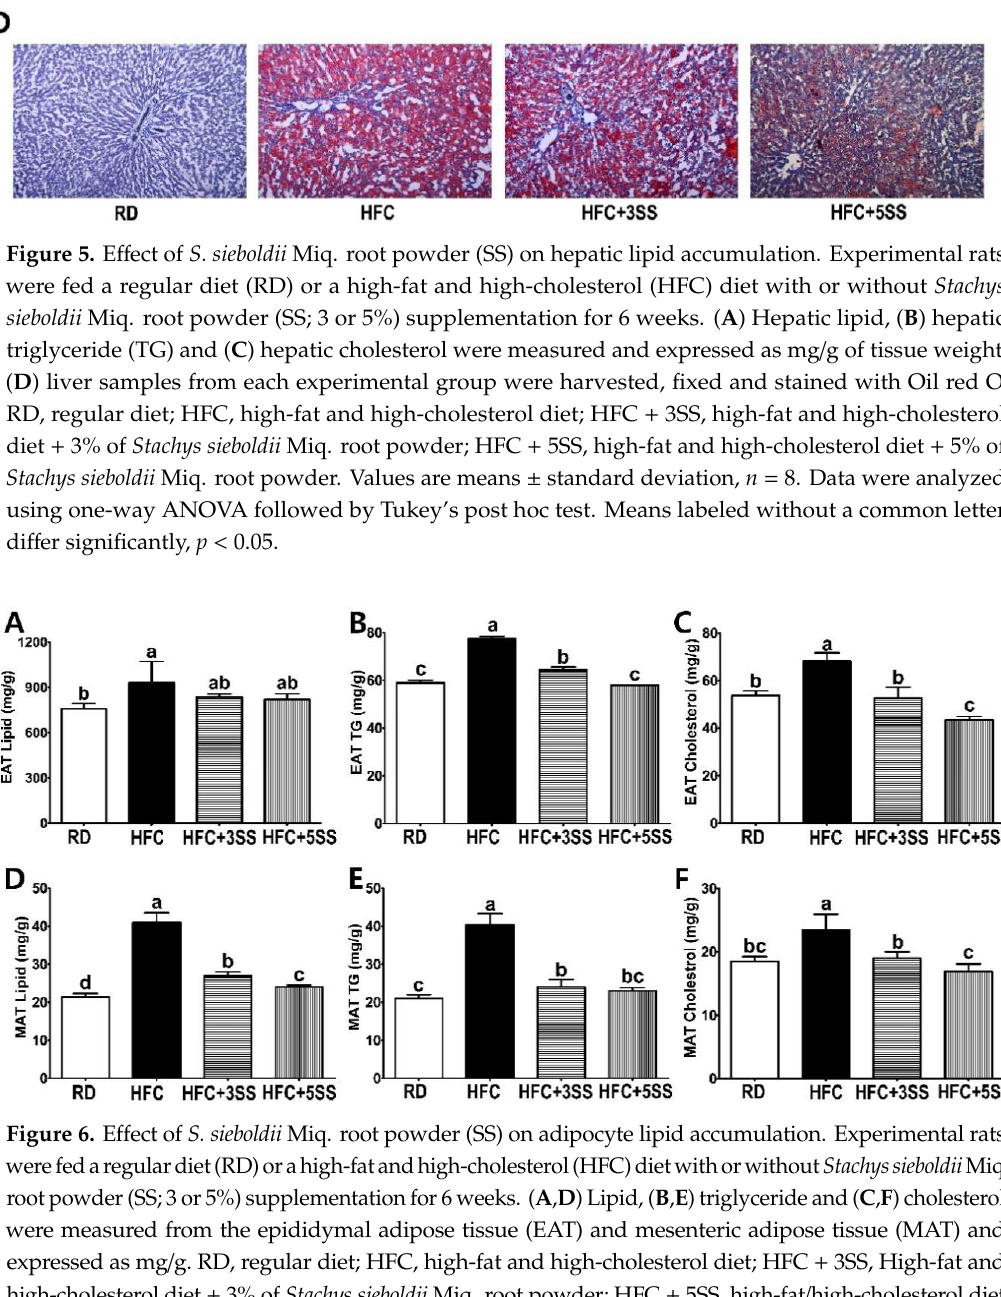
Figure 7. Effect of S. sieboldii Miq. root powder (SS) on adipocyte size. Experimental rats were fed a regular diet (RD) or a high-fat and high-cholesterol (HFC) diet with or without Stachys sieboldii Miq. root powder (SS; 3 or 5%) supplementation for 6 weeks. The epididymal adipose tissue (EAT) was stained with Hematoxylin and Eosin (HE). Magnification, 100×. The EAT surface area was quantified using the Image J program. ( A ) Representative EAT images; ( B ) Quantification of the surface area of EAT. RD, regular diet; HFC, high-fat and high-cholesterol diet; HFC + 3SS, High-fat and high- cholesterol diet + 3% of Stachys sieboldii Miq. root powder; HFC + 5SS, high-fat and high-cholesterol diet + 5% of Stachys sieboldii Miq. root powder. Values are means ± standard deviation, n = 8. Data were analyzed using one-way ANOVA followed by Tukey’s post hoc test. Means labeled without a common letter differ significantly, p < 0.05.